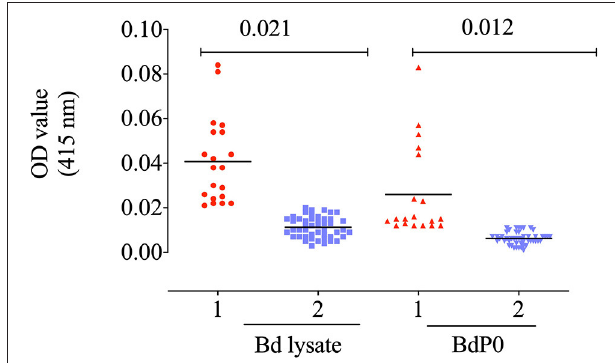
FIGURE 2 | Immune reactivity of recombinant rBdP0. ELISA reactivity with bovine serum samples utilizing rBdEBP and B. divergens lysate. Positive sera are in lane 1; negative sera are in lane 2. A bar represents the cutoff value.